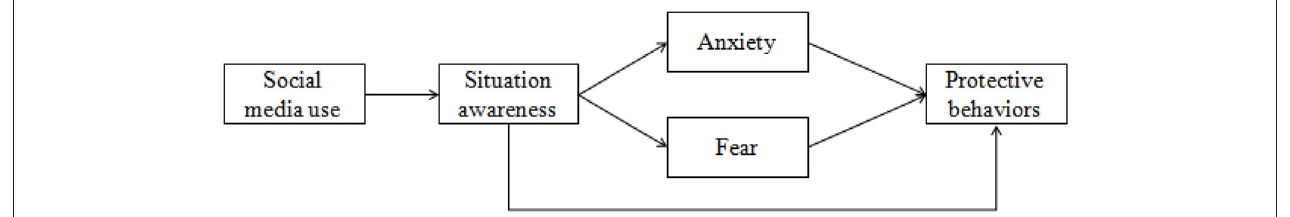
FIGURE 1 | Hypothesized